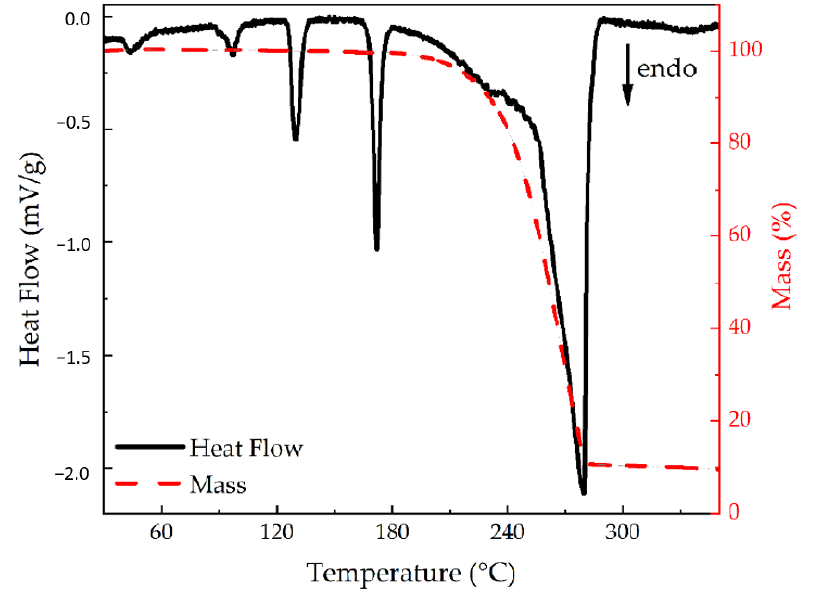
Figure 2. DTA-TG curves for ammonium nitrate (V).